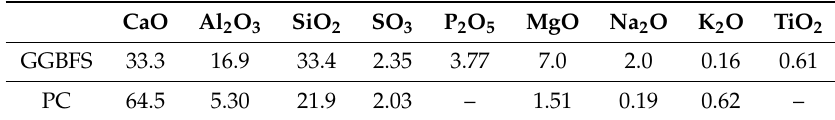
Table 1. Chemical composition of the ground granulated blast furnace slag (GGBFS) and the Portland cement (PC) (wt %)